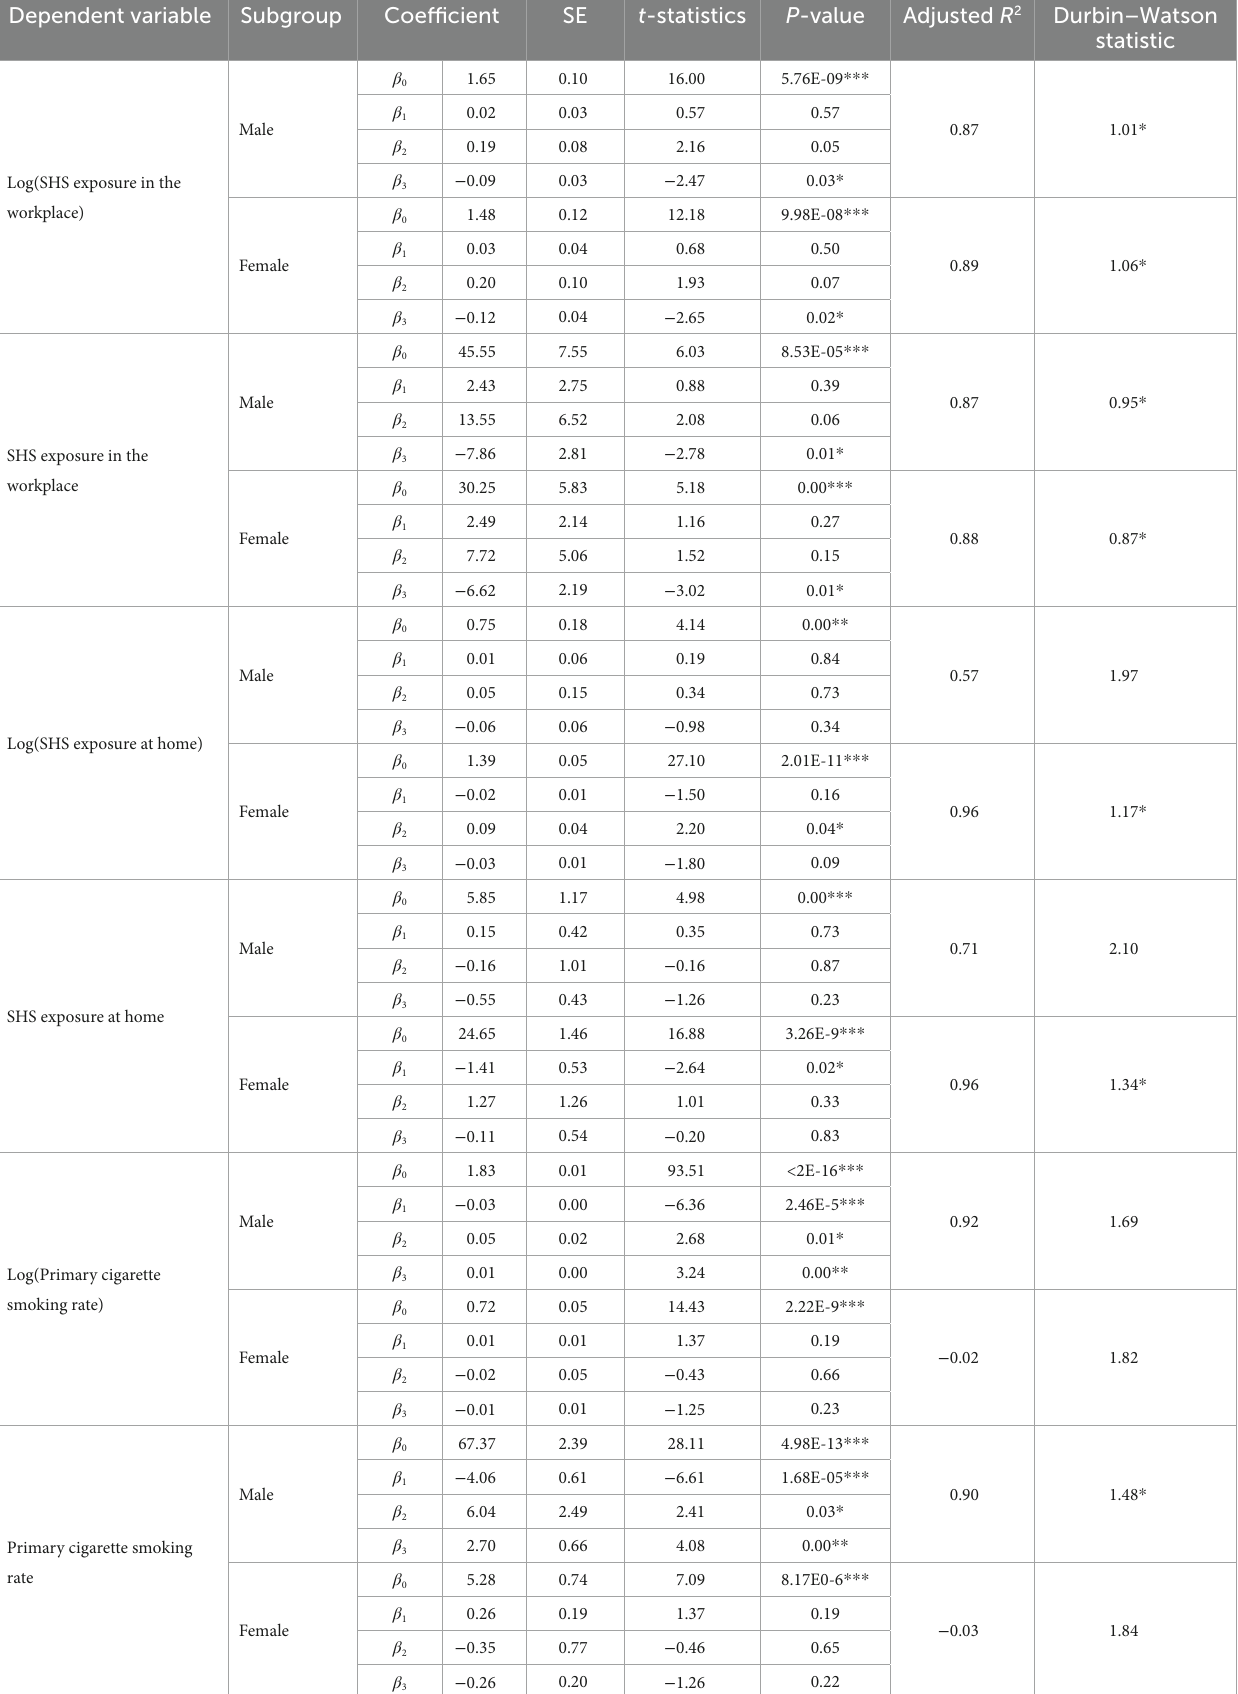
TABLE 2 Subgroup analysis of secondhand smoke (SHS) exposure before and after the implementation of smoke-free policies by